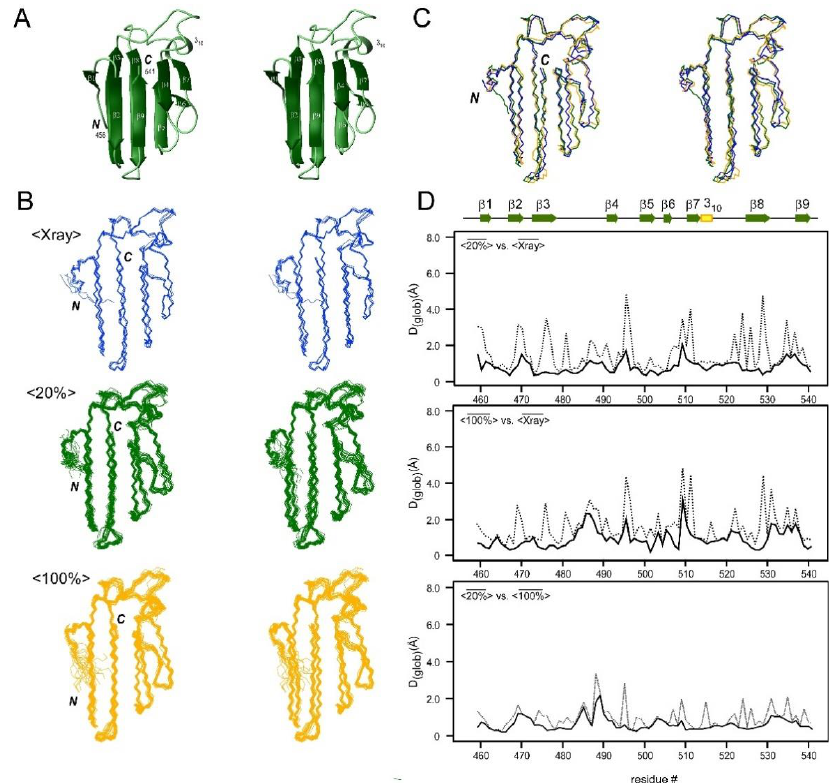
Figure 3. ( A ) A stereoview of the cartoon model of the lowest energy NMR conformer of CBM64